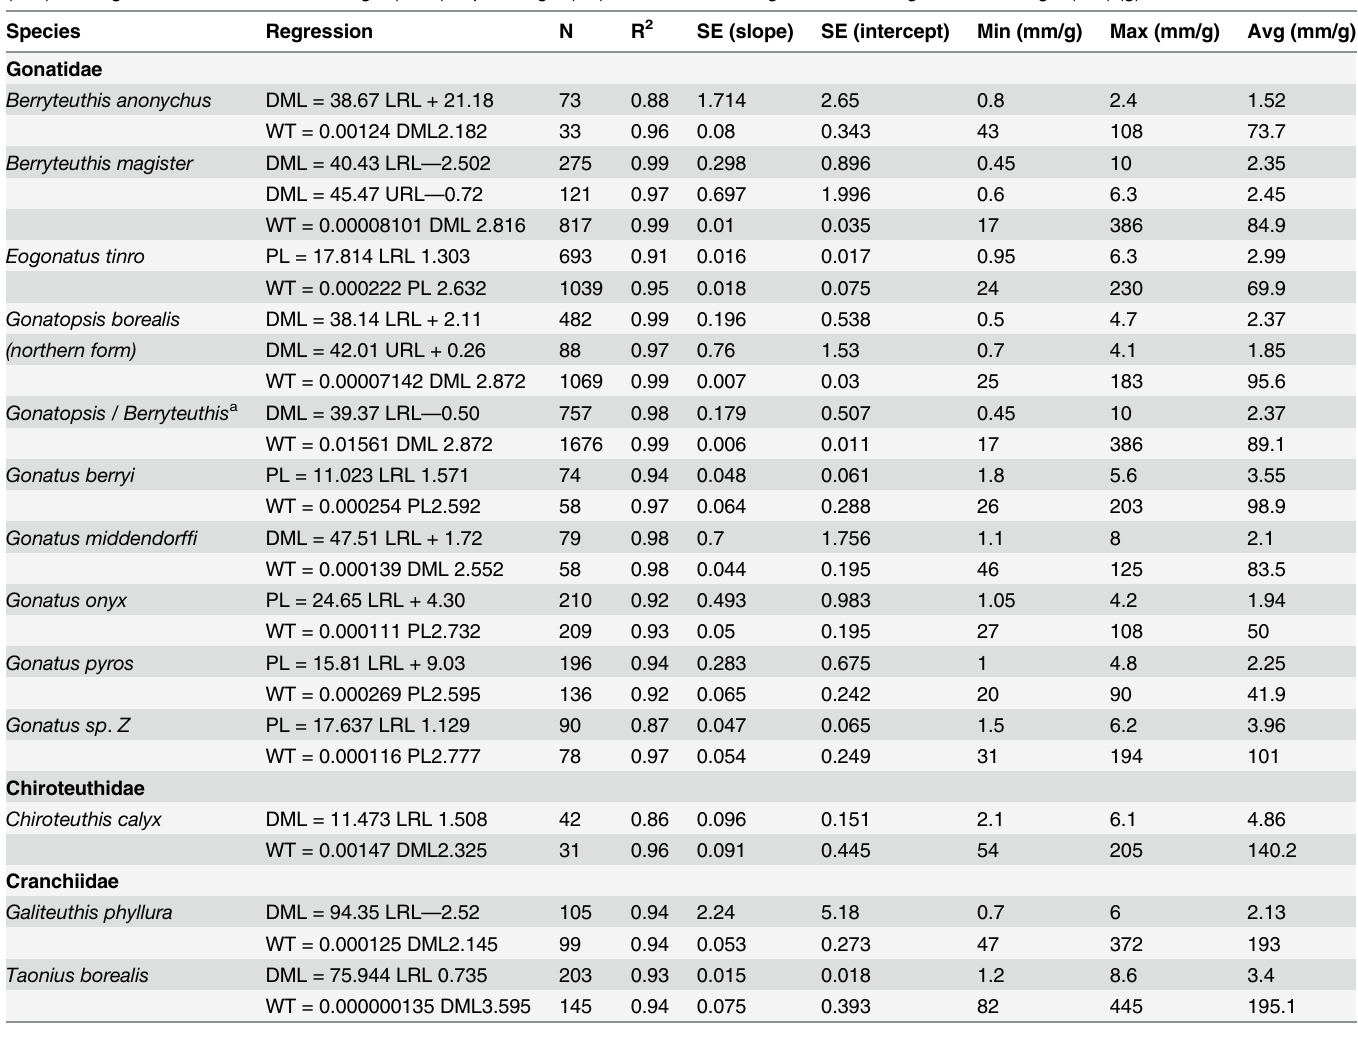
Table 2. Cephalopod length and weight regression equations. Lower beak rostral length (LRL) and upper beak rostral length (URL) were measured (mm) and regressed on dorsal mantle length (DML) or pen length (PL). Dorsal mantle length or PL was regressed on weight (WT) (g).